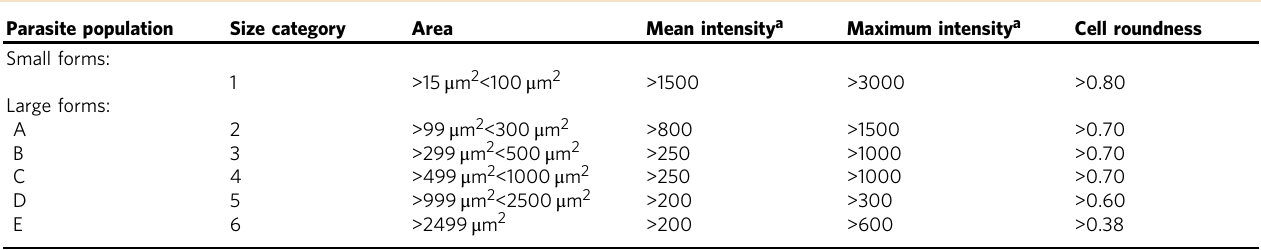
Table 1 High-content imaging and analysis of Plasmodium liver stage (LS) parasites Parasite population Size category Area Mean intensity a Maximum intensity a Cell roundness Small